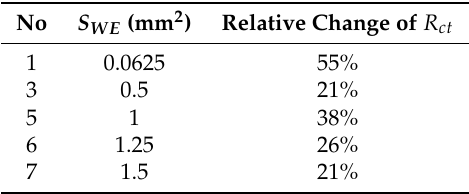
Table 2. Relative change of R ct for every type of